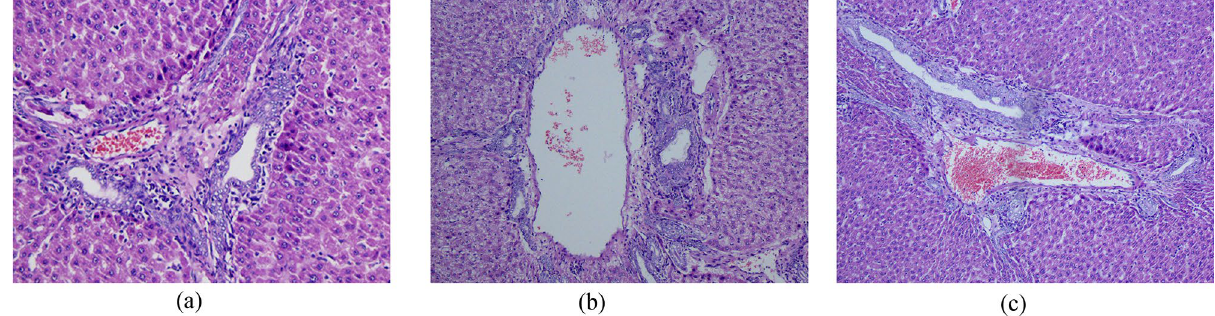
Figure 4. Hepatic histopathological of rats of normal group ( a ), model control group ( b ) and test group ( c